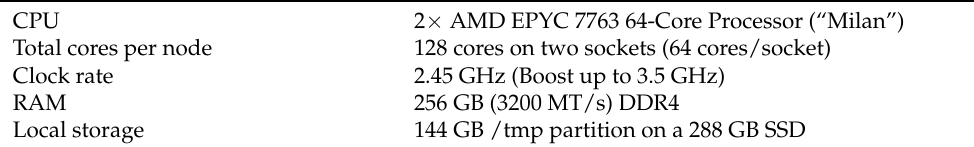
Table 1. Node specifications for